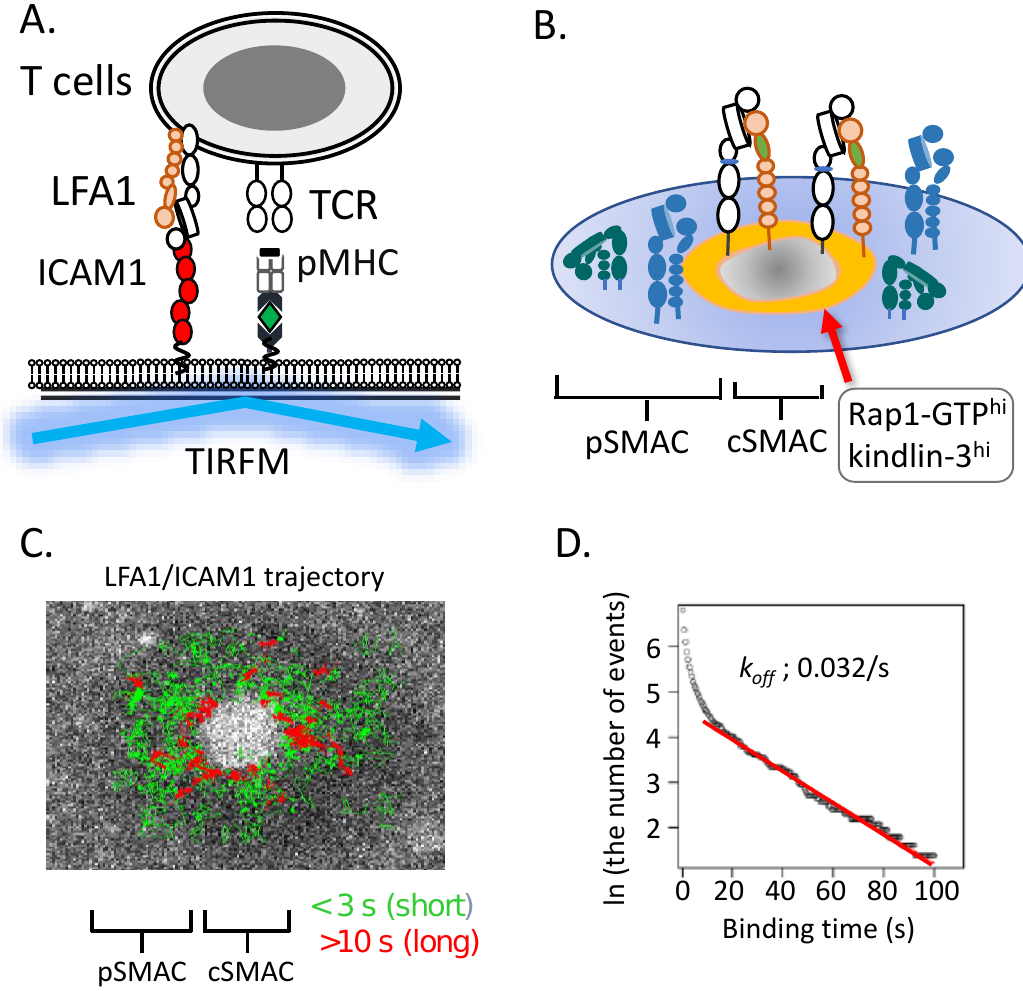
Figure 3. LFA1/ICAM1 interactions in immunological synapse. ( A ). Schematic representation of the experimental setting of single-molecule live imaging with TIRFM. Planar lipid bilayers incorporating fluorescently-labelled ICAM1 and peptide/MHC are used as surrogate antigen-presenting cells. ( B ). Immunological synapse with central SMAC (TCR/pMHC cluster) and pSMAC (LFA1/ICAM1). The inner pSMAC regions exhibiting high amounts of Rap1-GTP and kindlin-3 with high-affinity LFA1 are indicated. ( C ). Trajectories of LFA1-bound ICAM1 in IS. The trajectories with bound lifetime less than 3 s (green) and longer than 10 s (red) are shown [35]. ( D ). The semilogarithmic plot of LFA1/ICAM1 binding times and event numbers in IS. The slope (red) of the fitting line is k off (dissociation rate constant) of the stable binding longer than 10 s